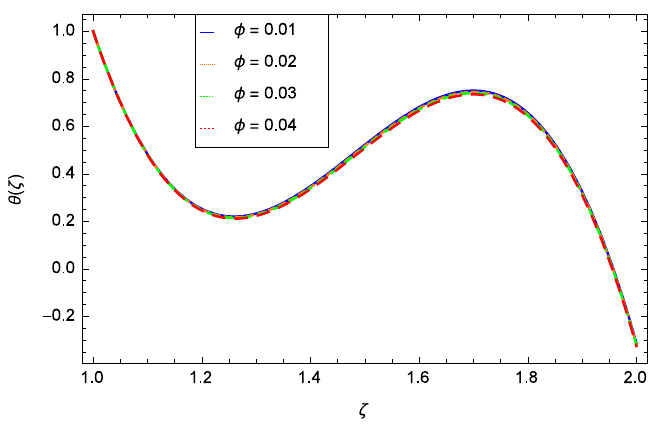
Figure 9. Non-dimensional temperature θ ( ζ ) sketch for h = − 1.10, β 1 = 1.70, M = 0.10, Re = 0.70, Pr = 6.80 and various values of φ (CuO-H 2 O).